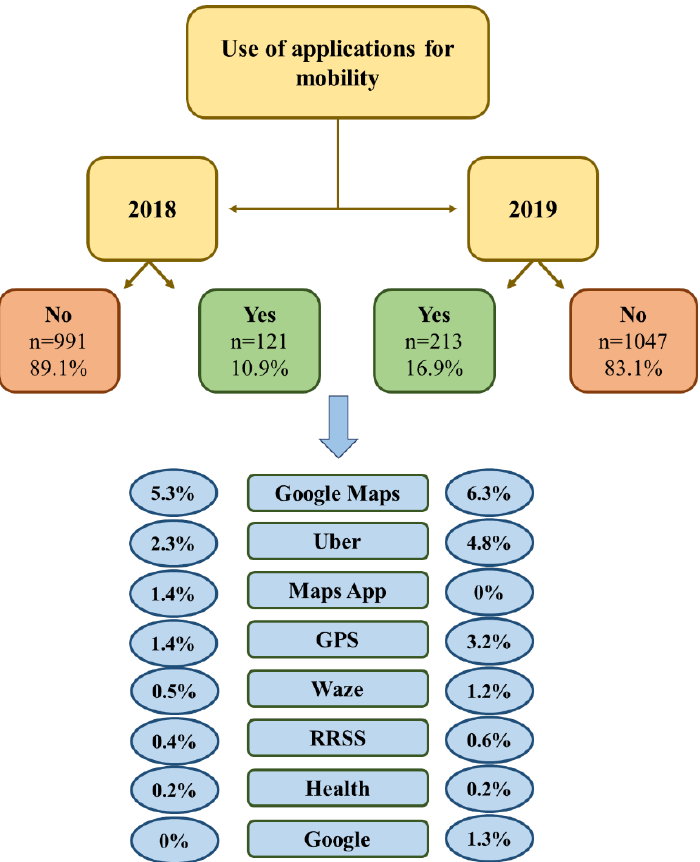
Figure 2. Applications used for displacements.